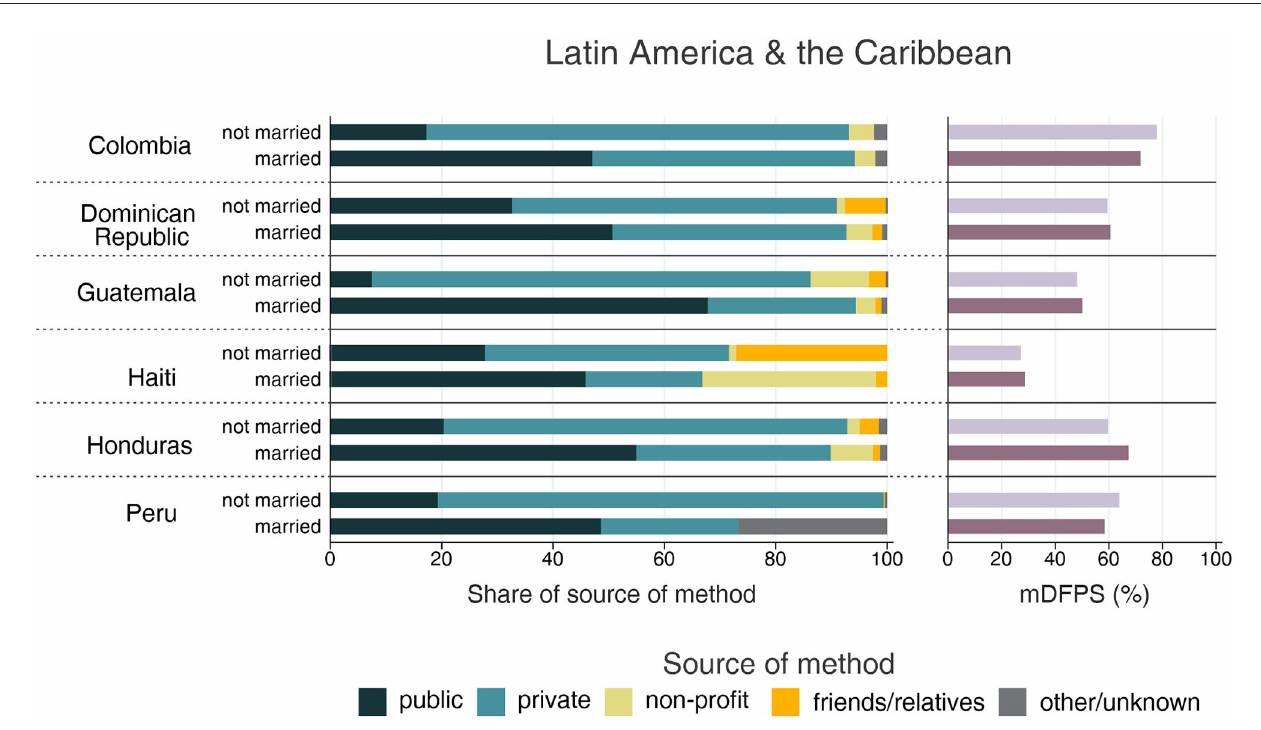
FIGURE8 Demand for family planning satisfied by modern methods (mDFPS) and share of source of method by adolescent’s marital status in Latin America and the Caribbean. Source: DHS, 2010-2021. Countries missing information on never married women or with fewer than 25 cases have been suppressed, or with fewer than 25 cases have been